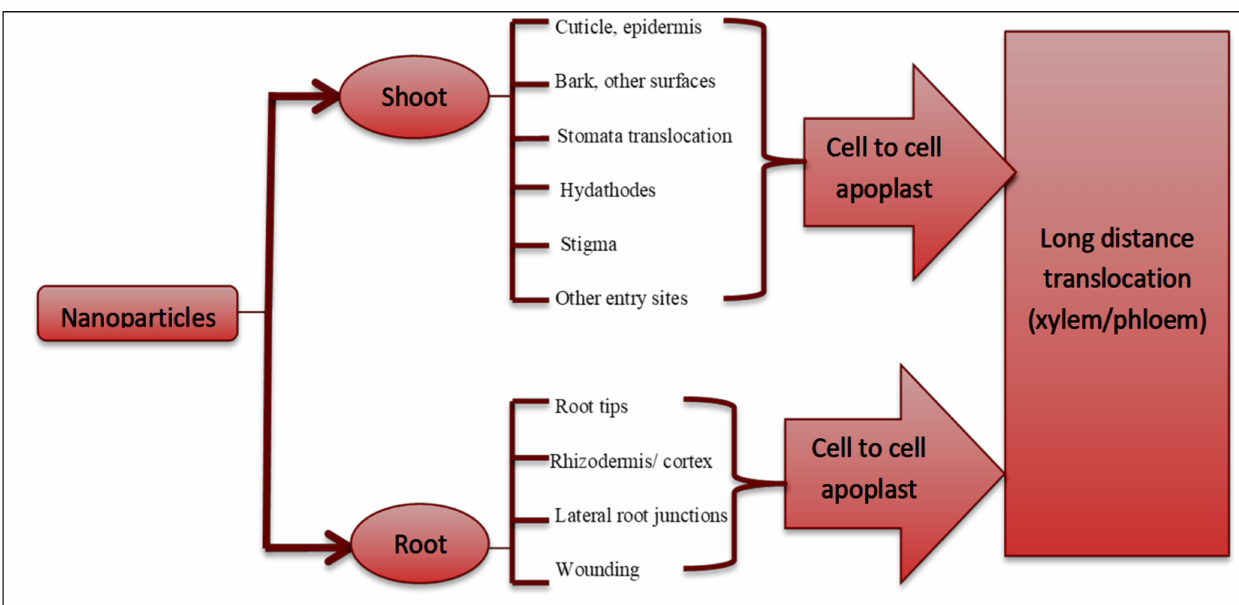
Figure 3. Putative pathways of nanoparticle uptake and translocation in plants. Redrawn and adapted from Tarafdar